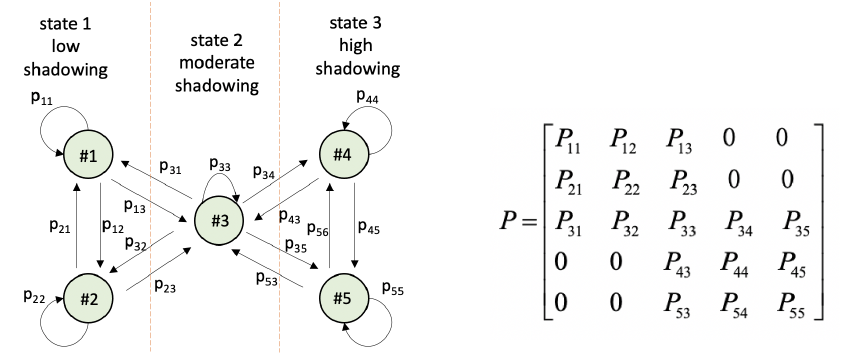
Figure 6. Five-state Markov channel model